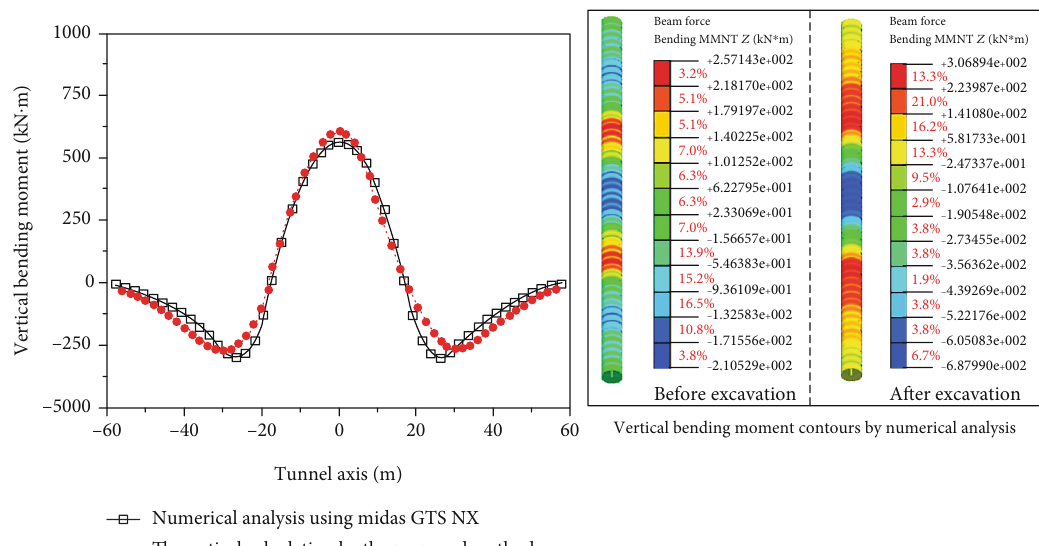
Figure 10: Excavation-induced tunnel vertical bending moments by numerical and theoretical